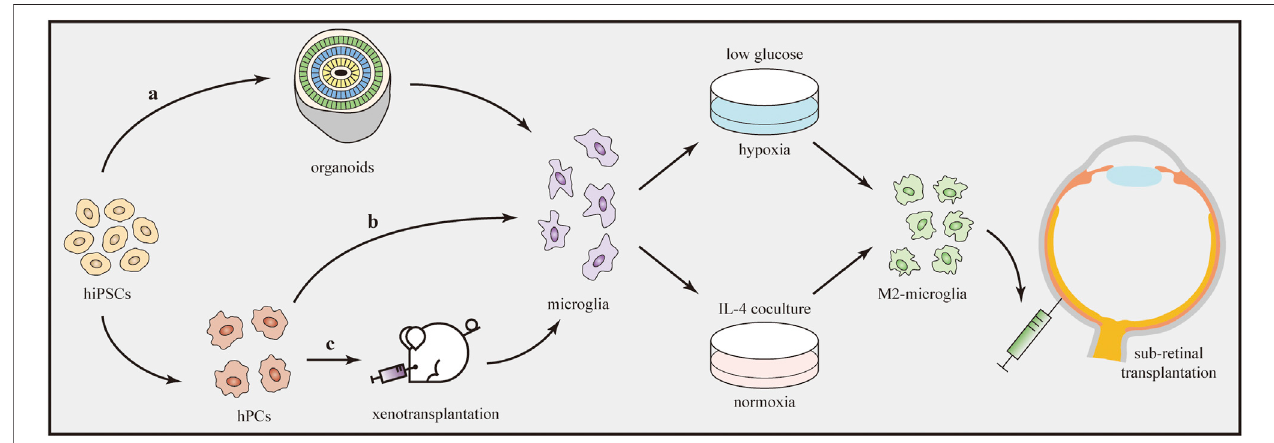
FIGURE 4 | Transplantation of iPSC-derived M2 microglia. Microglia can be generated from hiPSCs through three techniques (a – c) . Afterwards, microglia are induced to the M2 phenotype by using oxygen – glucose deprivation technique or IL-4 co-culture treatment. Direct transplantation of M2 microglia into the subretinal space can in fl uence the immune microenvironment and alleviate retinal in fl ammation.